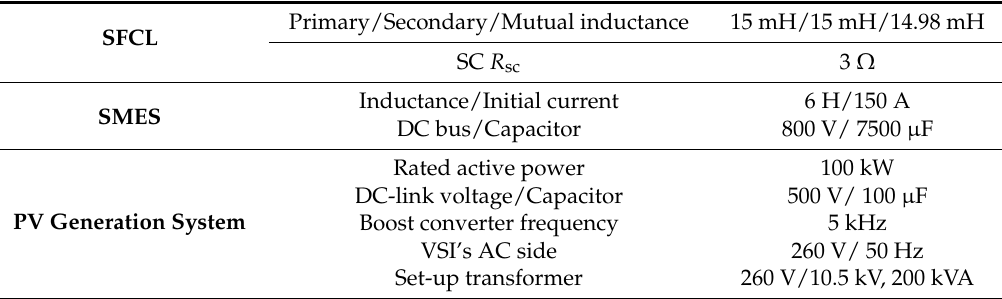
Table 1. Main simulation parameters of the demonstrated system. SC: superconducting coil SFCL